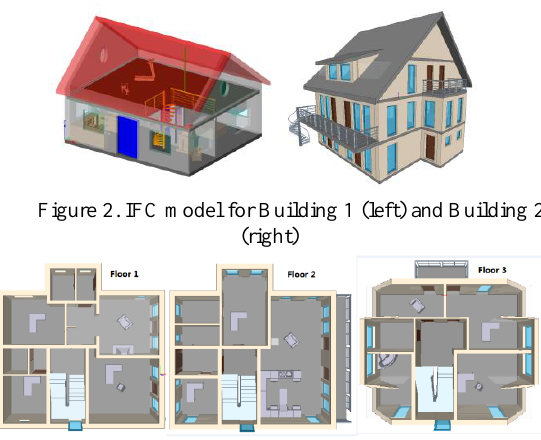
Figure 3. Multi-floors models of Building